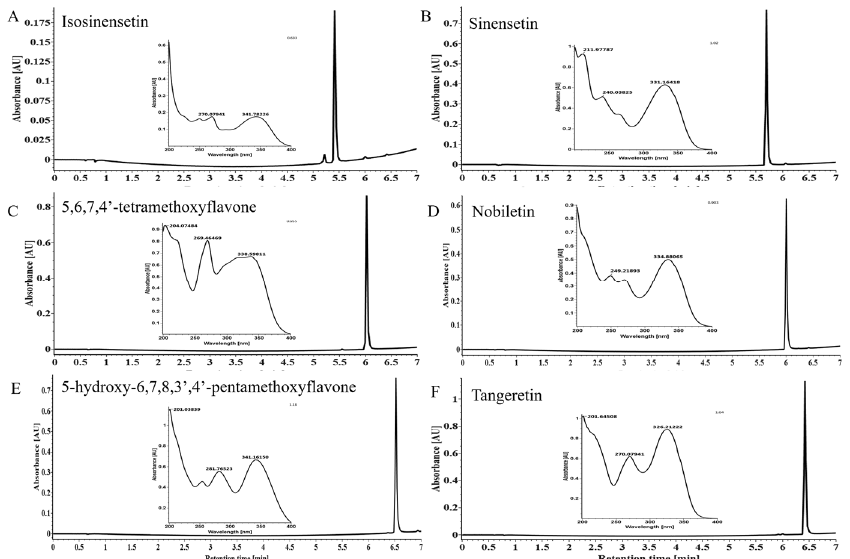
Figure 6. UPLC chromatograms and UV spectrums of isosinensetin ( A ), sinensetin ( B ), 5,6,7,4′- UPLC chromatograms and UV spectrums of isosinensetin ( A ), sinensetin ( B ), tetramethoxyflavone ( C ), nobiletin ( D ), 5-hydroxy-6,7,8,3′,4′-pentamethoxyflavone ( E ), and 5,6,7,4 (cid:48) -tetramethoxyflavone ( C ), nobiletin ( D ), 5-hydroxy-6,7,8,3 (cid:48) ,4 (cid:48) -pentamethoxyflavone ( E ), tangeretin ( F ). and tangeretin ( F